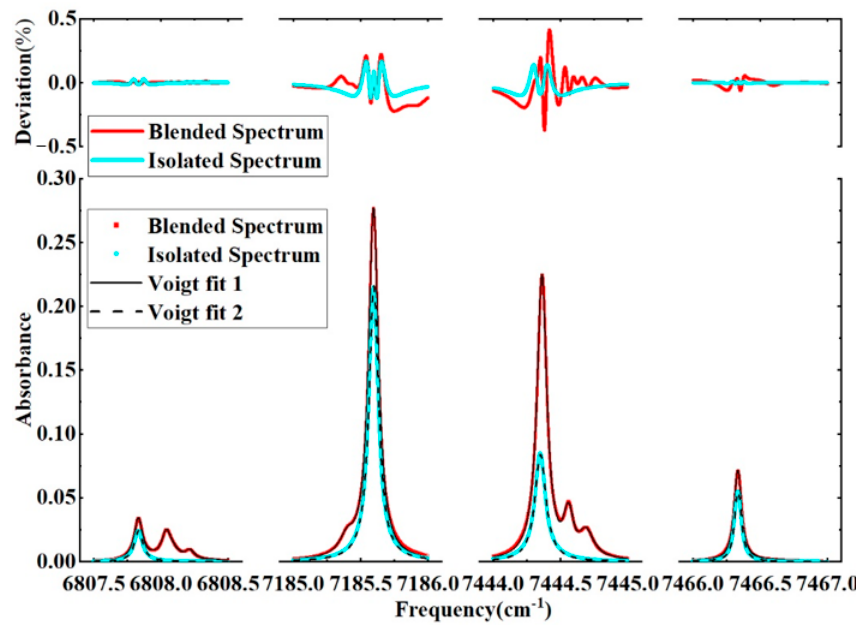
Figure 8. Schematic diagram of the absorption signal simulation and